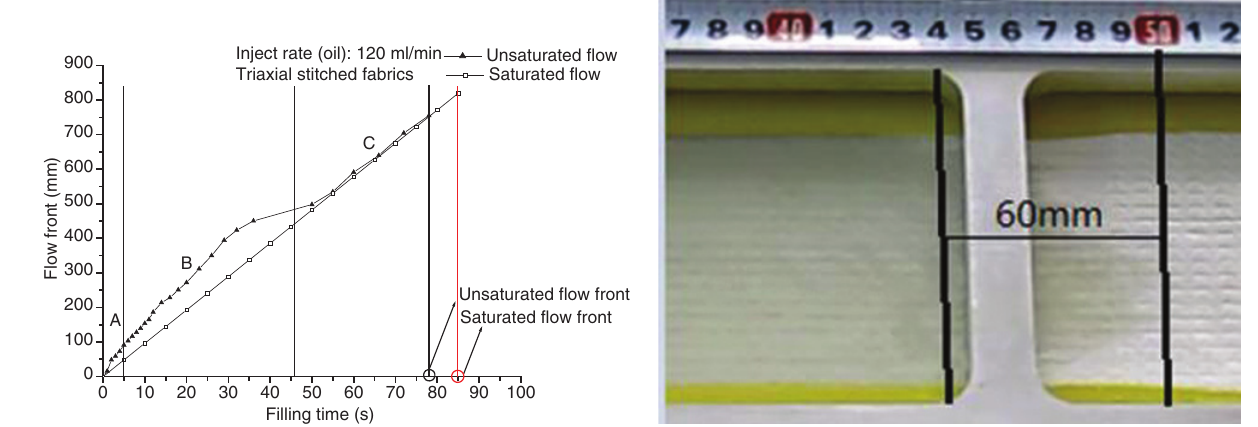
Figure 6: Position of unsaturated flow front against time. Figure 7: Flow fronts at the same